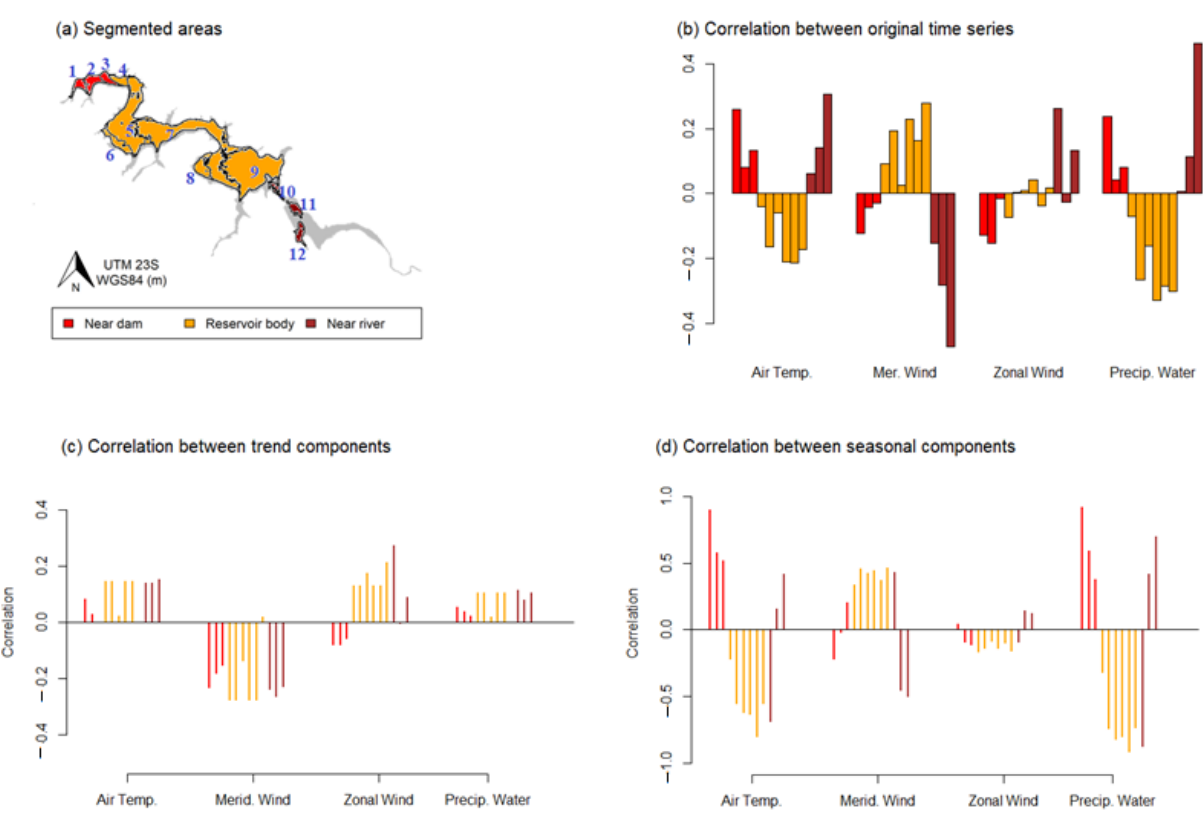
Figure 10. Reservoir divided into twelve segmented areas, highlighting the three compartments by color ( a ), correlations between original time series of climate variables (air temperature, meridional and zonal wind, and precipitable water) and the NDVI of each segmented area ( b ), correlations between the trend ( c ), and seasonality ( d ) components of the NDVI time series for the segmented areas and climate variables. In ( b – d ), bars and vertical lines represent the correlations for areas 1 to 12 grouped according to the reservoir compartment they represent (near dam, reservoir body, and near river).